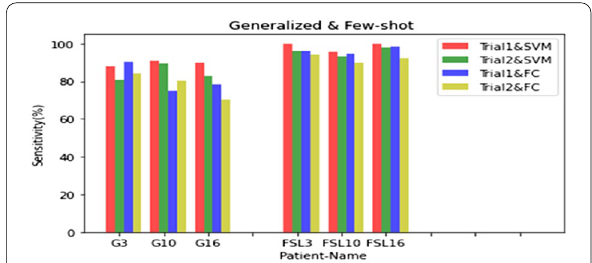
Fig. 4 Sensitivity chart for three CHB–MIT patients with different methods and trials. (G3 Generalizable method for patient Chb03, = FSL3 FSL method for patient =